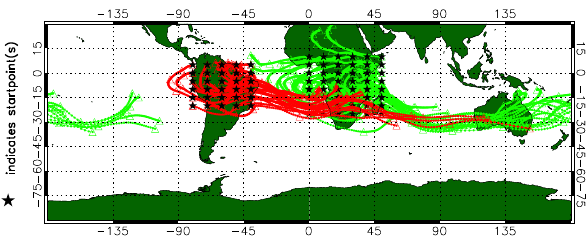
Fig. 9. HYSPLIT 5-day forward trajectories originating from Cen- tral Africa (green) and Amazon (red) regions on 1 August 2003 at 185 hPa. The regions were chosen based on MODIS fire activity for this month in Fig. 6 Fig. 10. HYSPLIT 10-day backward trajectories initiated from Eu- rope on 15 August 2003 at 185 hPa. Pathways are influenced by four areas coloured by: (1) Dark blue – North America, (2) Red – South–East Asia, (3) Green – Northern Africa and (4) Light blue – Europe.